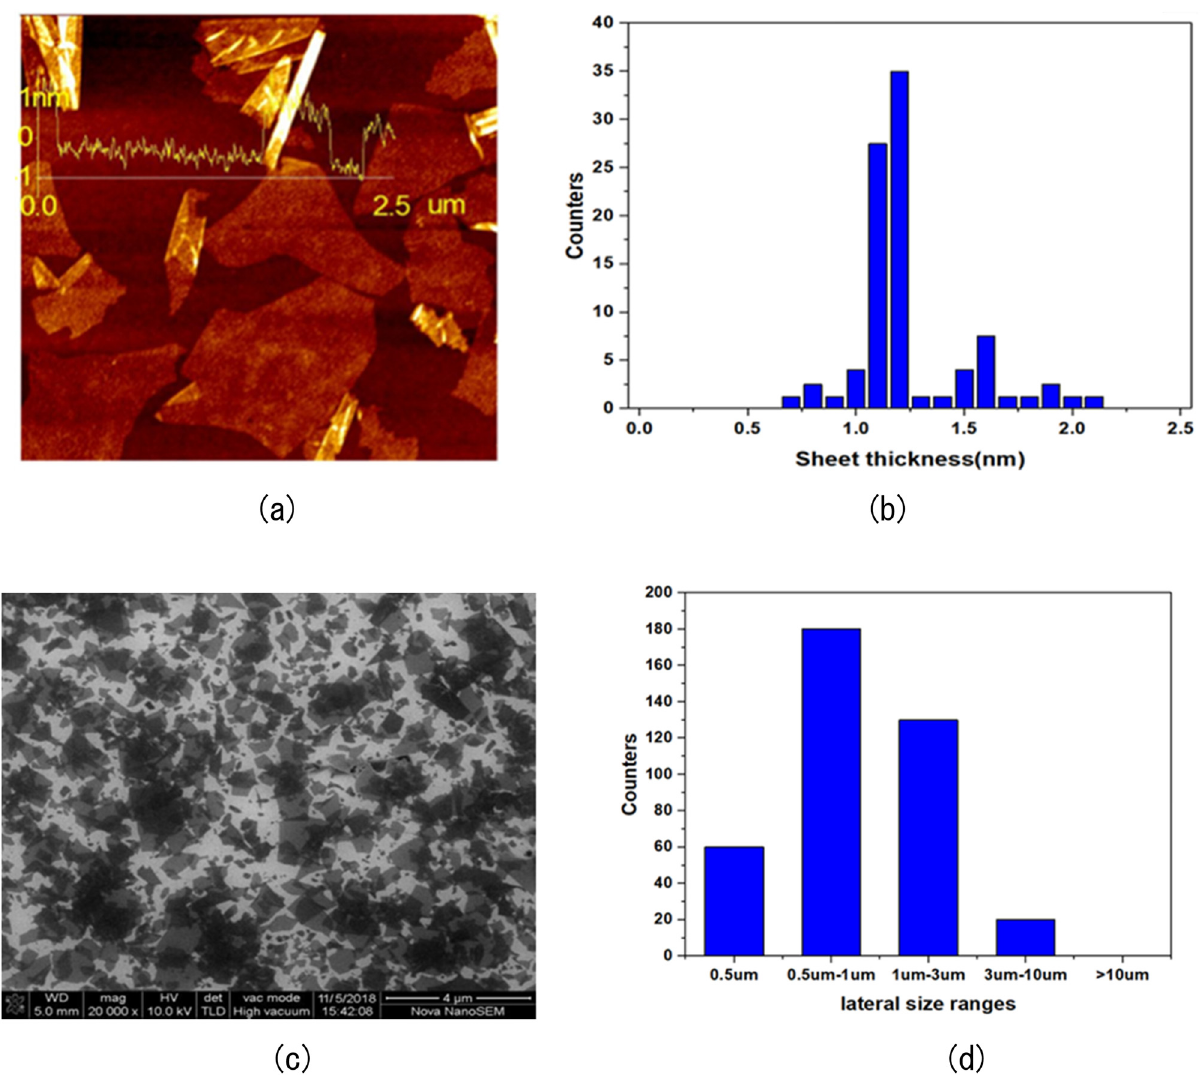
Figure 3: Characterization of GO. ( a ) typical AFM image of GO, ( b ) statistics of the thickness distribution of GO, ( c ) typical SEM image of GO, and ( d ) statistics of the lateral size distribution of GO.